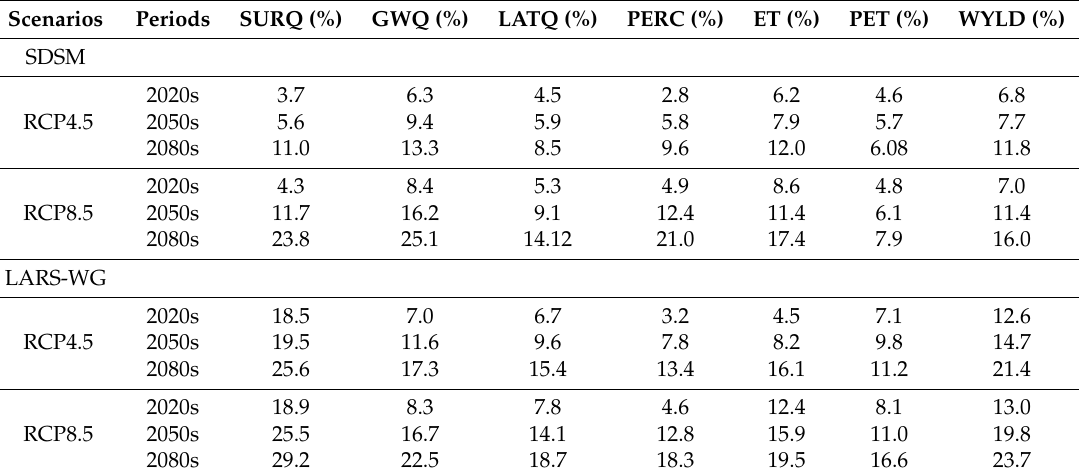
Table 7. Comparison of mean annual water balance under di ff erent